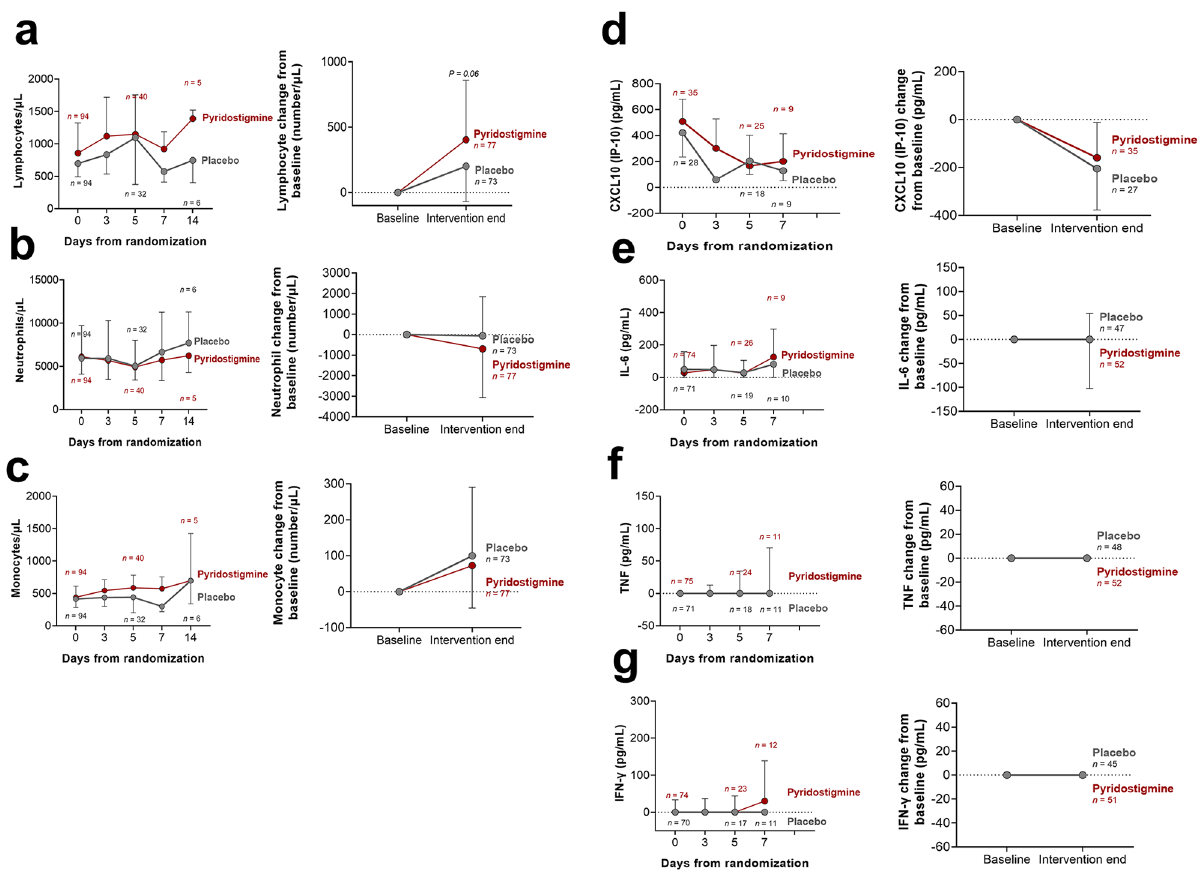
Fig. 3 Between-group time course of circulating hematological and inflammatory markers of severity. Circulating lymphocyte (a), neutrophil (b), monocyte (c), CXCL-10 (d), IL-6 (e), TNF (f), and IFN-γ (g) values. Sample sizes at each time point are indicated. All data are shown as median ± IQR. Only the upper quartile for the group with the highest value and the lower quartile for the group with the smallest value are shown to avoid image